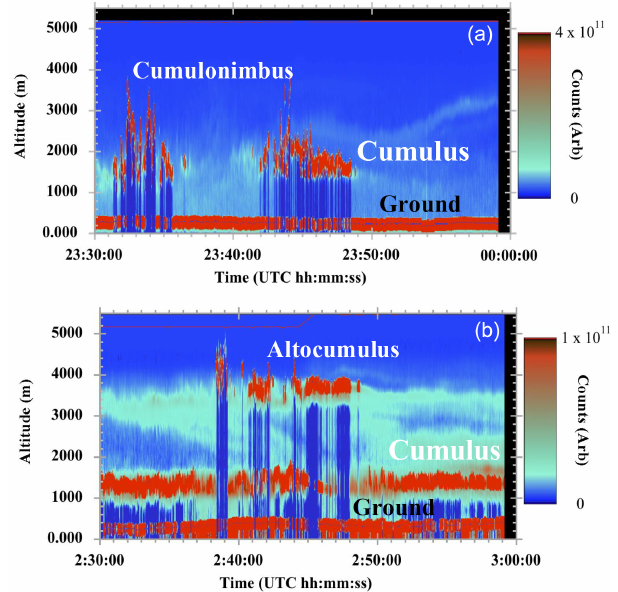
Figure 11. Vertical cross sections of range-corrected backscattered pulse energy for segment A and B marked in Fig. 10. The lidar returns from the ground are at the bottom, and cloud returns are at a variety of altitudes from 1 to 4km. The red lines on the top of plots indicate aircraft flight altitudes.